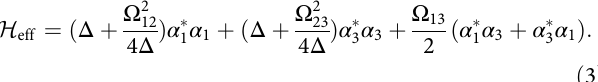
Fig. 2 Hybridization between all three modes. a Measured spectrum of the three-mode system when the frequency of R 2 is far off-resonance from that of mode R 1 by a detuning Δ 12 /2 π ~ 70 kHz (here, V DC f m2 . An avoided level crossing is observed when three-mode system when the detuning is Δ 12 /2 π ~ 180 kHz (here, V DC as the black dashed box shown in a ). Here, a strongly avoided level crossing appears when f m3 approaches f m1 . The strengths of the direct couplings extracted from the measured spectrum are Ω 12 /2 π = 240 kHz and Ω 23 /2 π = 170 kHz. c , d Spectra calculated using the theoretical model for the three modes (Eq. (2)) and coupling constants Ω 12 and Ω 23 . Δ 12 /2 π = 700 kHz in c and Δ 12 /2 π = 180 kHz in